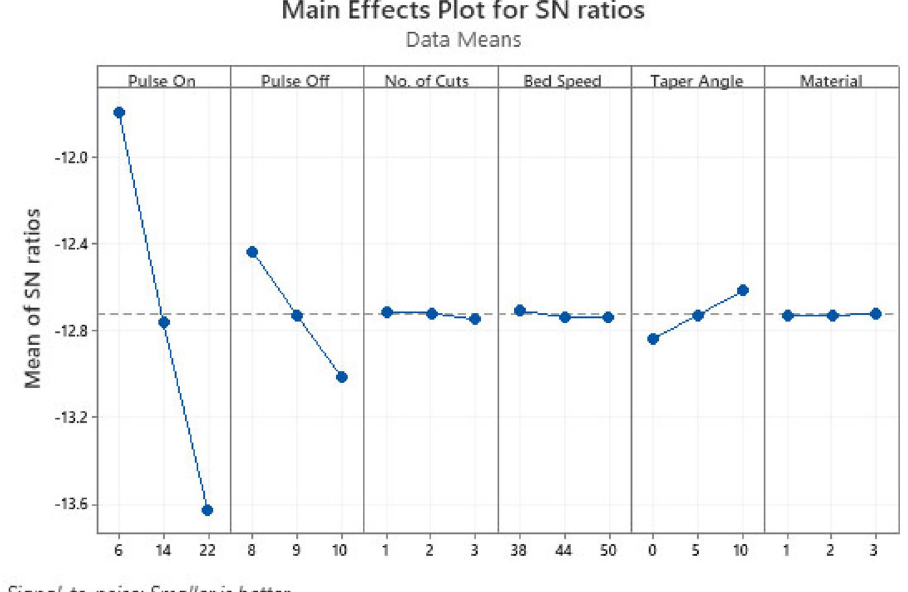
Fig. 10 Main effects plot for S/N ratios of R a